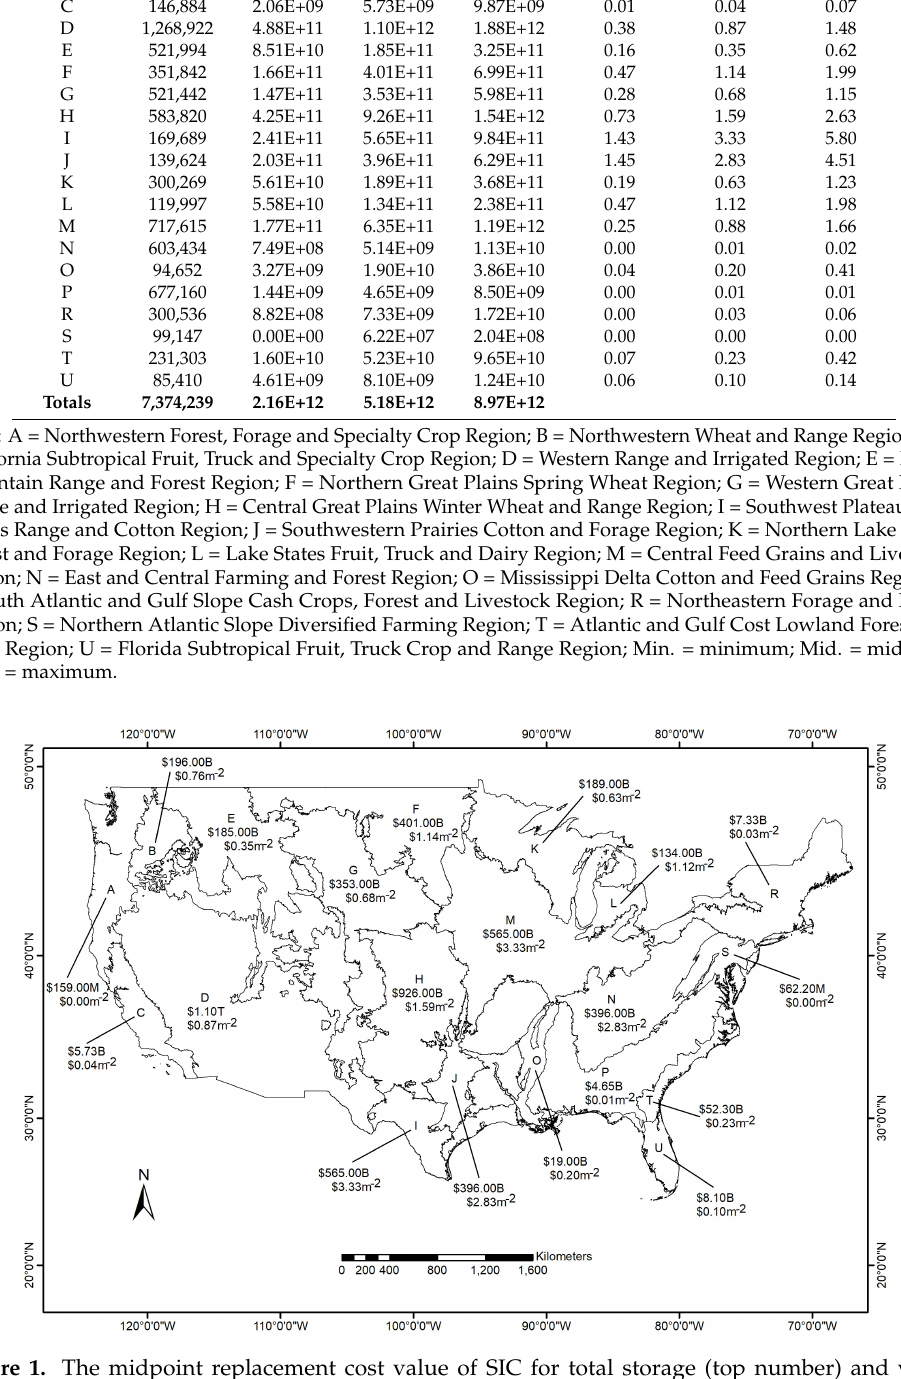
Figure 1. The midpoint replacement cost value of SIC for total storage (top number) and value Figure 1. Seismological scenario. ( a ) Seismicity distribution in Central Italy recorded from 24 August to normalized by area (bottom number) for different Land Resources Regions (LRRs) in the contiguous 29 November 2016 (red circles) [15], superimposed on the 1 arcsec Shuttle Radar Topography Mission United States based on [9] and a 2014 average price for limestone of $10.42 per U.S. ton (SRTM) Digital Elevation Model (DEM) of the zone: the 1997–1998 Colfiorito and the 2009 L’Aquila seismic sequences are also shown (blue dots). The seismic events with M w 5.4 are represented by ≥ red stars and the associated focal mechanisms are also reported in the map. The black lines represent the main faults located in this area: the Mt. Gorzano Fault (MGF) and the Mt. Vettore Fault System (MVFS); ( b ) Seismicity distribution as a function of magnitude (the higher the magnitude, the bigger the circles) and day of occurrence (from green to red circles). The seismic events with M w 5.4 are ≥ also indicated and are represented by red stars. The black lines represent the section profiles reported in panels ( b – e ), in which the relocated hypocenters of the occurred earthquakes and the main inferred geological alignments (black lines) are projected. Until now, an extended literature exists but a univocal point of view on the role played by the causative faults, involved in the NEQ, has not yet been reached [4,17–20]. In particular, Cheloni et al. [4] show, in addition to the SW-dipping faults, the possible role played by: (i) a NE-dipping normal fault antithetic to the MVFS and MGF and illuminated by the aftershocks distribution; (ii) a preexisting compressional low-angle structure, likely related to a segment of the Sibillini Thrust. Scognamiglio et al. [20] proposed that a secondary rupture plane is necessary to fit their inversion of recorded ground-velocity waveforms and coseismic GPS displacements; moreover, a multi-fault source model is consistent with the deformation pattern resulting from DInSAR interferograms. Moreover, Scognamiglio et al. [20] provides an interpretation of the unusual non-double couple component inferred from the moment tensor solution, which is anomalous if compared with other moment tensor solutions in this sector of the Apennines during the present and past seismic sequences. In this work, we exploit seismological data and multi-orbit ALOS-2 DInSAR measurements to investigate the main effects due to the 30 October 2016 NEQ, with particular emphasis given to the evaluation of the rock volumes affected by uplift and subsidence phenomena. Starting from the